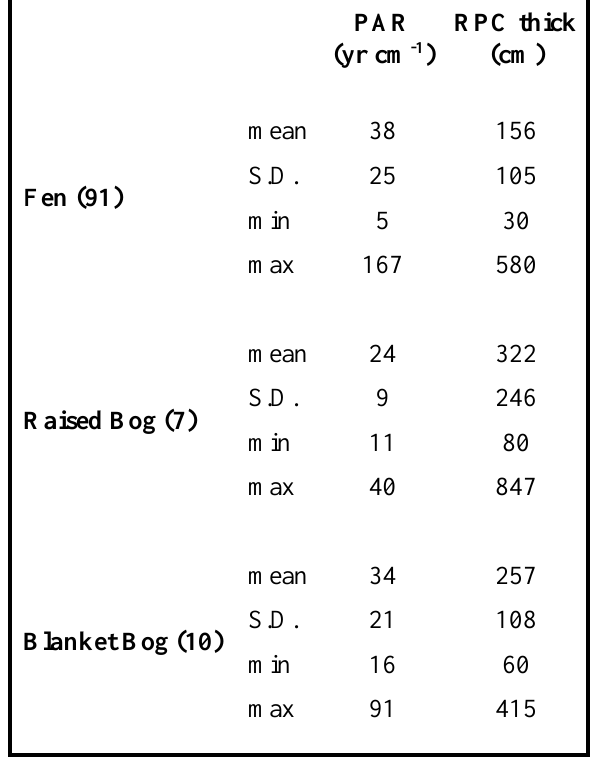
Table 1. Vertical peat accumulation rates (PAR) and thickness of the most recently-formed peat cycle (RPC) for different peatland